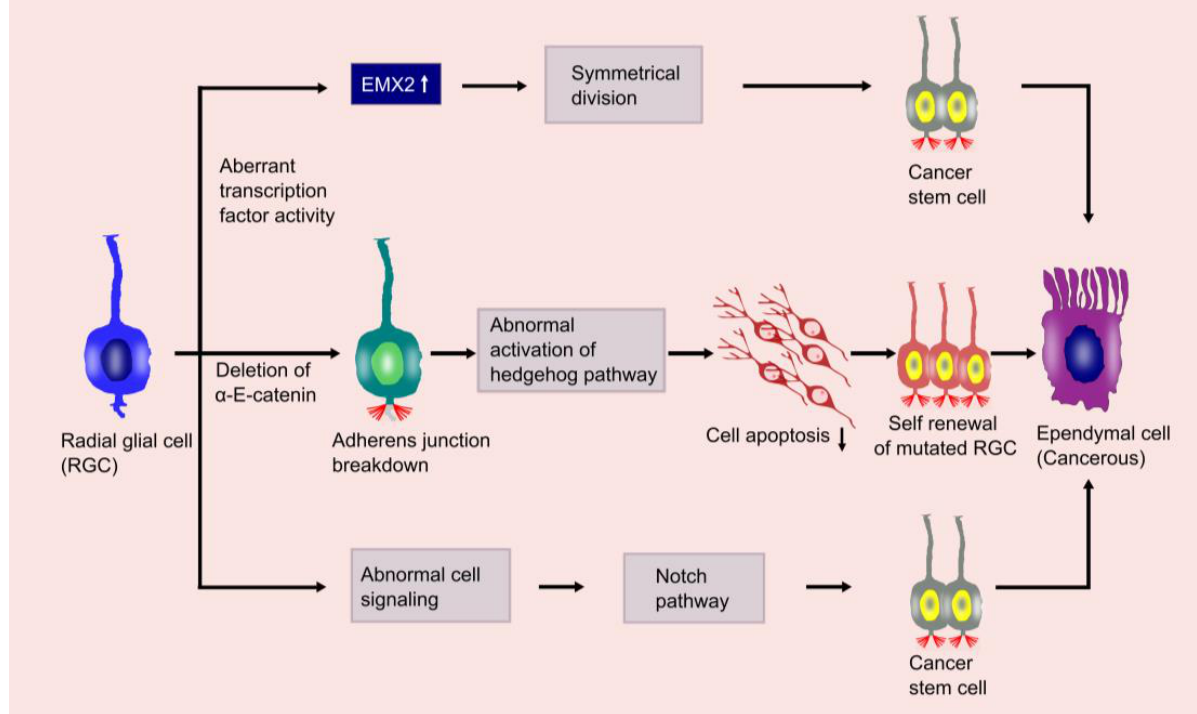
Figure 1. Tumorigenesis of ependymal cells. This figure illustrates the possible mechanism of tumorigenesis of ependymal cells from the radial glial cell (RGC). RGC mutation by aberrant transcription factor activity, adherens junction breakdown, or abnormal cell signaling transforms it into a cancer stem cell (CSC).